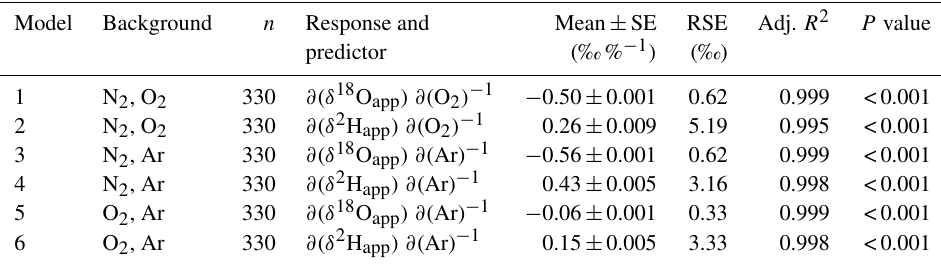
Table 2. Empirical models of the sensitivity of δ 18 O and δ 2 H values to each of the binary mixtures of N 2 , O 2 , and Ar. For significant predictors, coefficient estimates are given for β 5 in Eq. (4); see text. Overall model fit is summarized with the residual standard error (RSE), adjusted R 2 , and P